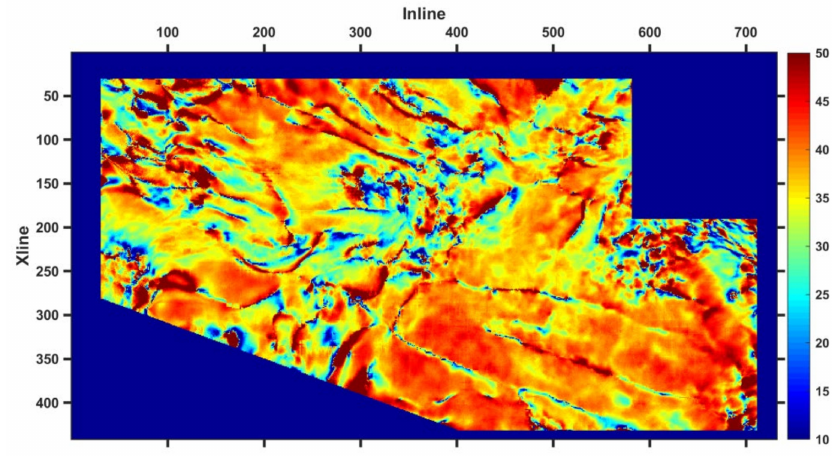
Figure 12. The instantaneous frequency attribute of the coal seam. 4. Instantaneous frequency bandwidth. The bandwidth attribute is the width between high and low cut frequency in seismic data. It mainly reflects the characteristics of seismic waveform in seismic data and can be used to analyze the heterogeneity of the formation, in its local extreme value location and where there are faults. Therefore, the application of this attribute is useful to identify of small faults in the study area. In Figure 13, the boundary, marked by an abrupt change in tone, is the theoretical location of the fault development, which is roughly consistent with the interpretation of results map.